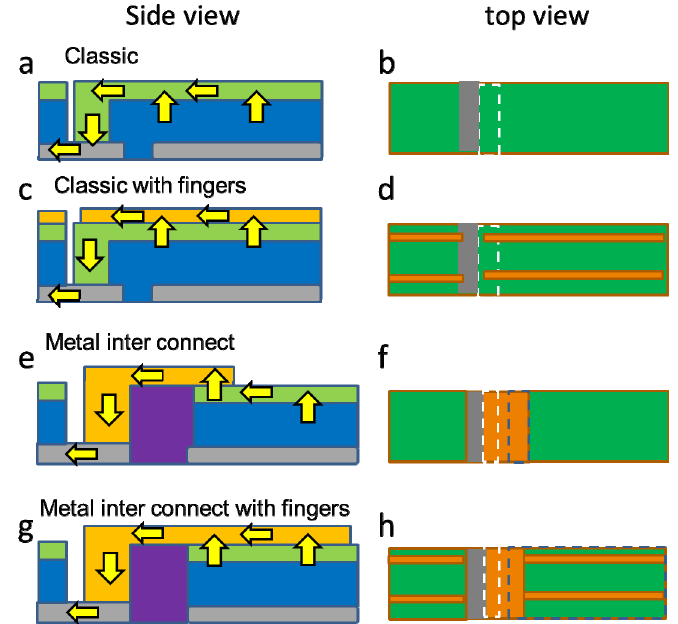
Figure 1. Schematic representations (not to scale) of different interconnection and cell layouts with a side view ( a , c , e , g ) and a top view ( b , d , f , h ). The top image shows the front contact (in green), the absorber material (in blue) and the back contact (in grey). In addition, the separation and interconnection layout between two adjacent cells is shown. The surface area of the TCO/back contact material interface is indicated by the white dashed box. The flow of current is depicted by the arrows. The second highest image shows the case where the front contact is supplemented by a metal grid (in orange), whereas the right image displays the area covered by the metal (not to scale). The third image shows the case of the metal interconnect, for which two material interfaces are important: the metal back contact area represented by the white dashed box and the metal/TCO contact areas represented by the blue dashed box.